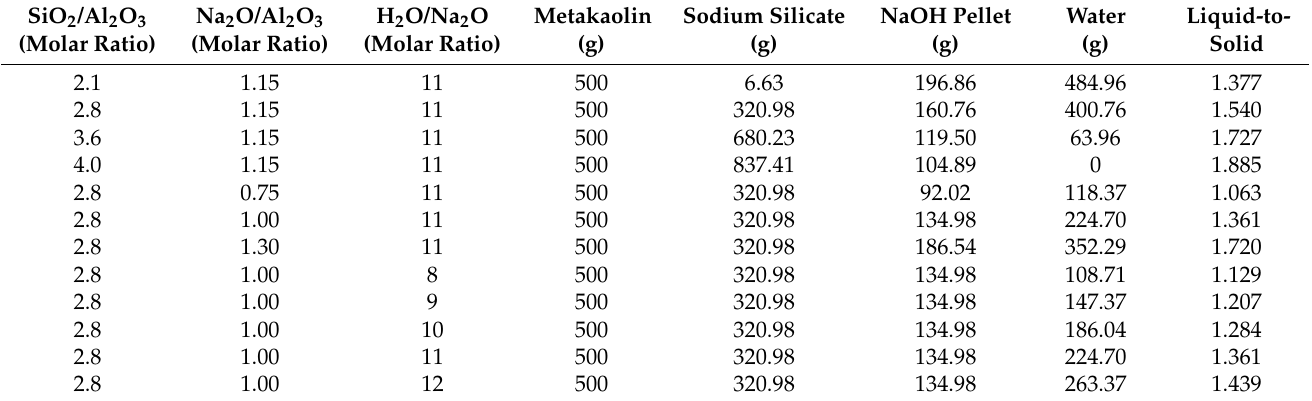
Figure 1. ( a ) XRD and ( b ) FTIR spectra of the metakaolin precursor. Table 2. Mix proportions of N-A-S-H geopolymers for engineering properties and further charac- terizations.